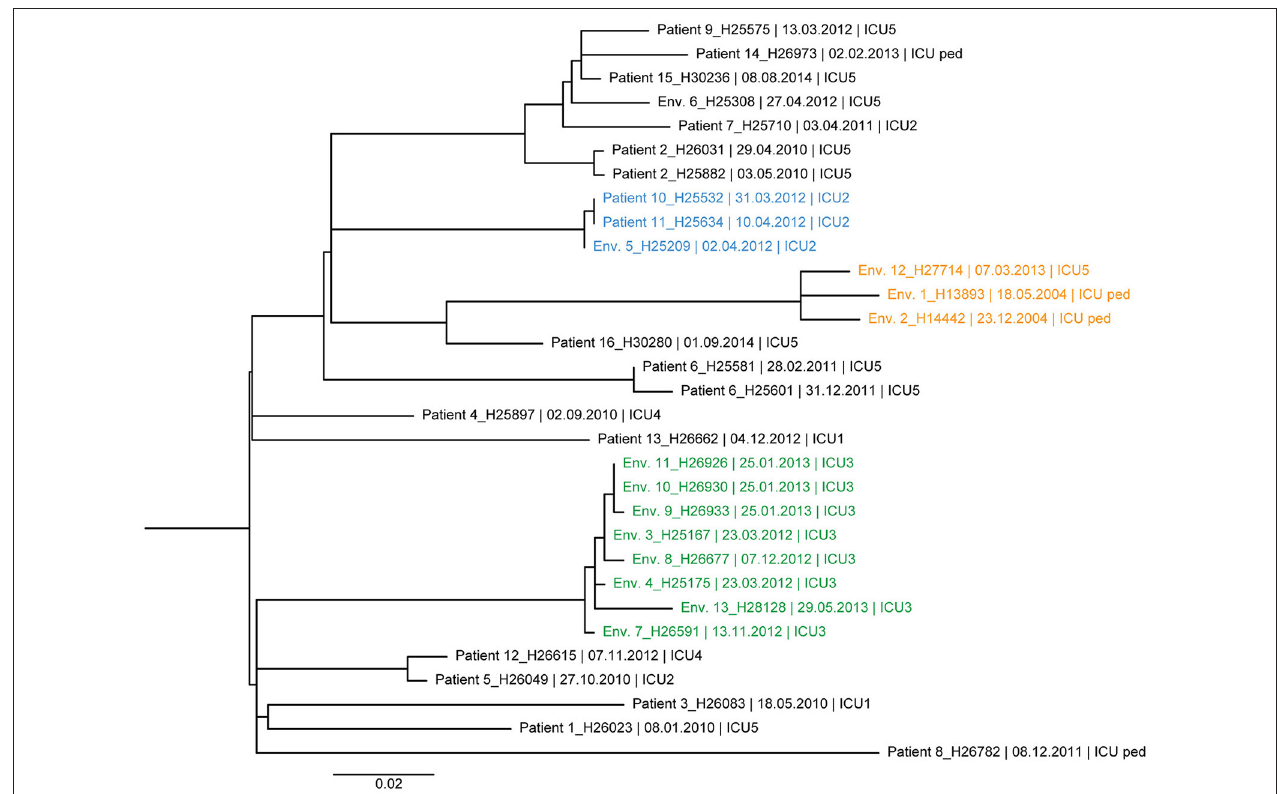
FIGURE 3 | Maximum likelihood tree based on SNP variable sites of all DLST 1–21 isolates. Isolate identification (patient or environment), date and unit of sampling are indicated. Isolates from the suspected outbreak are in blue. The three clades of highly similar isolates from the ICU 2 (0–1 SNP differences), ICU 5/ICU-pediatric (11–14 SNP differences), and burn unit (0–11 SNP differences) are colored in blue, orange, and green, respectively.